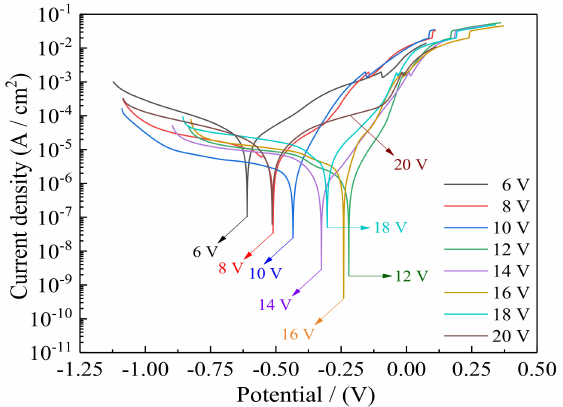
Figure 9. SEM micrographs of worn surfaces of Ni–Co–P alloy coatings: ( a ) 12 V, 60 ◦ C; ( b ) 20 V, 60 ◦ C; ( c ) 40 ◦ C, 12 V; and ( d ) 75 ◦ C, 12 V.